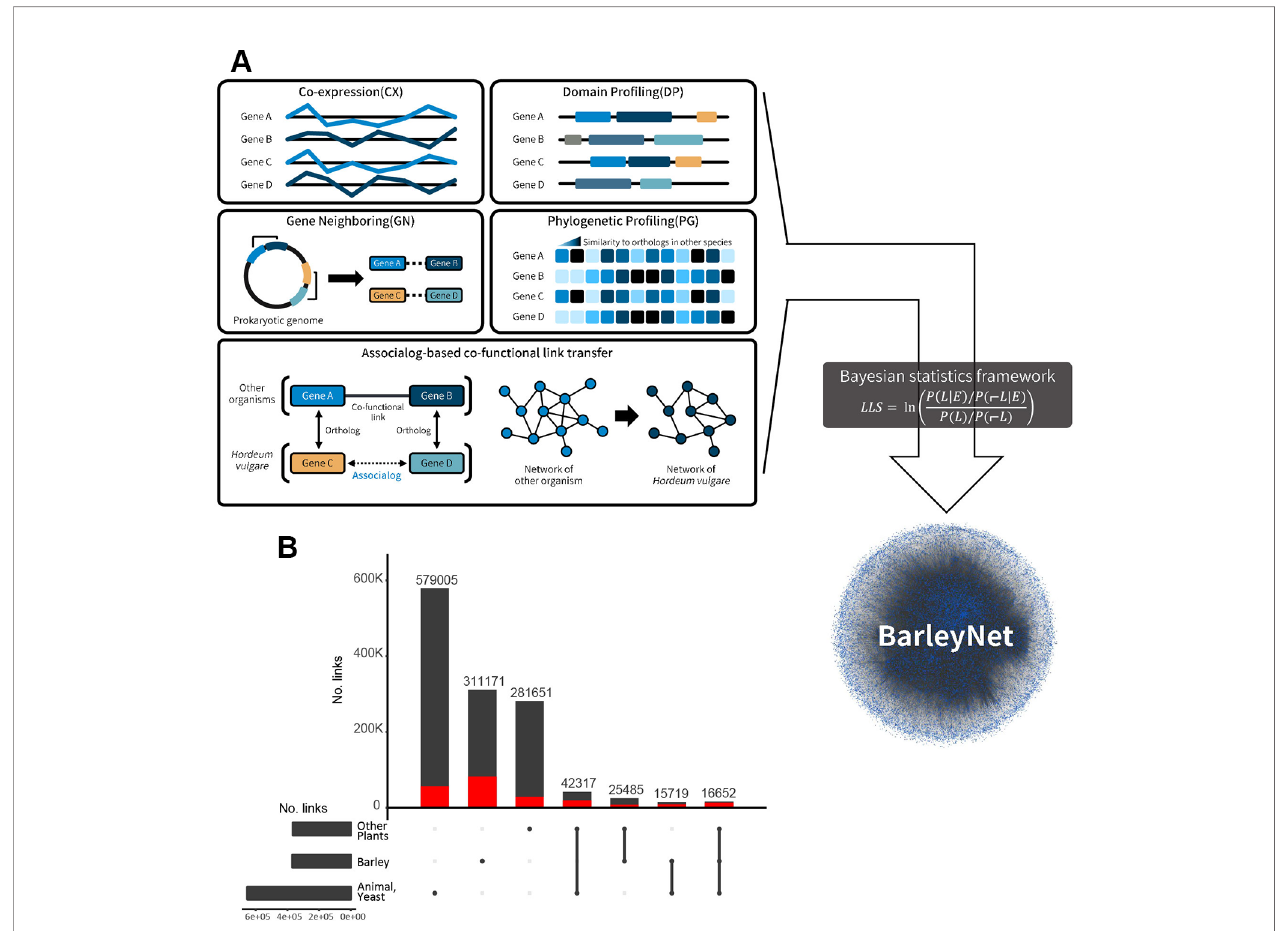
FIGURE 1 | Overview of BarleyNet. (A) BarleyNet was constructed by integrating functional associations between barley genes inferred from the co-expression of genes (CX), gene neighborhood (GN), association of protein domain composition pro fi les (DP), phylogenetic pro fi le association (PG), and those transferred from 21 networks previously constructed for other species based on functional association between orthologous proteins (associalog). (B) Summary of BarleyNet edge information with UpSet visualization. Network edges were classi fi ed into three groups based on the species of origin of the inferred co-functional association: “ barley, ” “ other plants ” and “ animals or yeast. ” The bar height represents the number of BarleyNet links for each species group or their combination. The red bar represents the number of links that are 20 fold more likely than gene pairs by random (i.e., high con fi dence